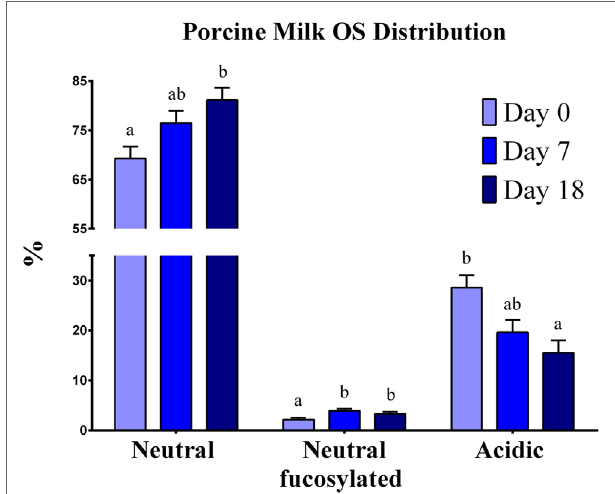
FigUre 1 | Oligosaccharide distribution in porcine milk . Results are expressed as the average of the relative abundance (%) of OS found in porcine milk from seven sows throughout the lactation period. Neutral, neutral-fucosylated, and acidic OS distributions exhibited changes by day ( P < 0.05) throughout lactation. a,b Indicate statistical differences among time of milk collection during the lactation period, where means that do not share a common superscript letter differ ( P < 0.05, HSD-Tukey